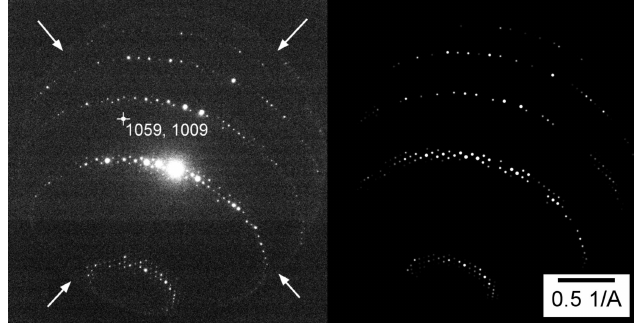
Figure 4 (Left) A diffraction frame and (right) its simulation, taken from dataset DS4. The arrows indicate an aperture limiting the field of view of the diffraction pattern, and the white cross with coordinates shows the refined position of the optical axis of the microscope (distortion centre) on the 2 k (cid:3) 2 k